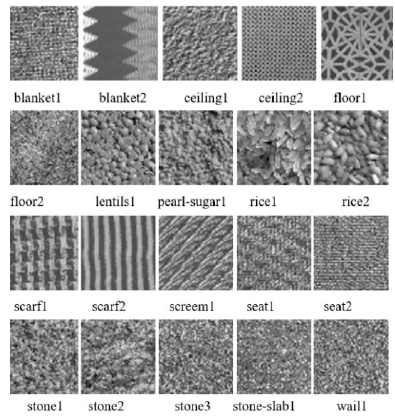
Figure 14. Instances samples of DS-Kylberg dataset.